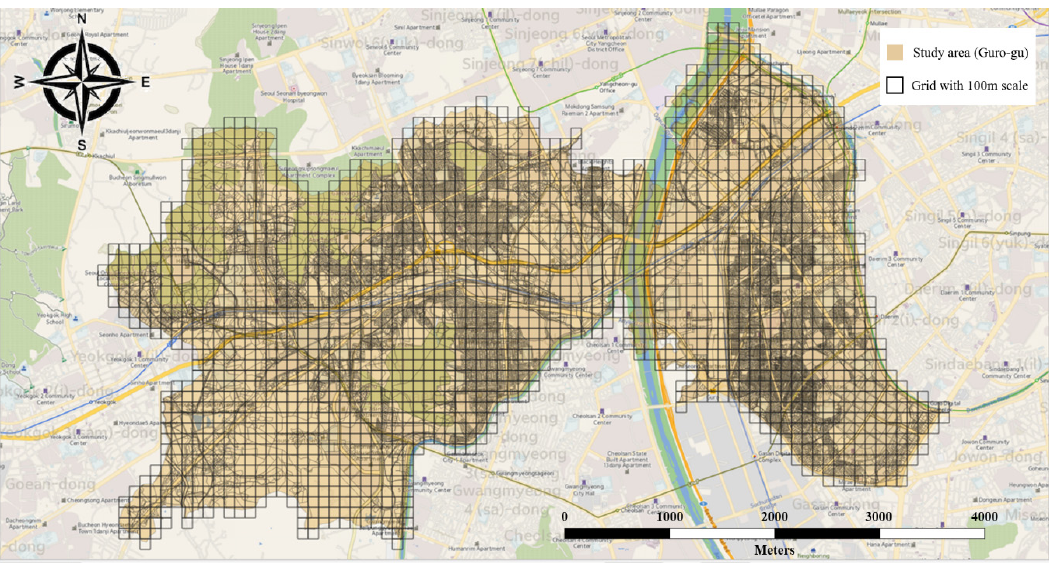
Figure 1. Study area divided by a 100 m scale grid.